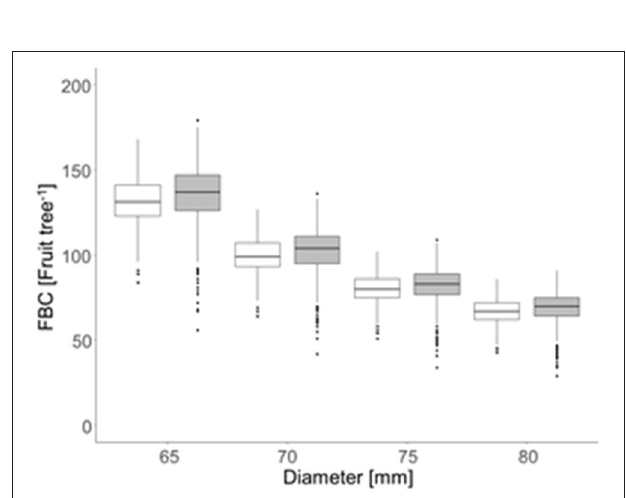
FIGURE 8 | Mean fruit-bearing capacity [FBC (fruit tree − 1 )] considering the four target fruit diameters (D) of the ‘Gala’/M.9 apple in 2018 (open box plots) and 2019 (gray box plots) for 996 trees per year in the period of 15 d before and after the highest daily fruit C-requirement (2018: 86–116 DAFB; 2019: 77–107